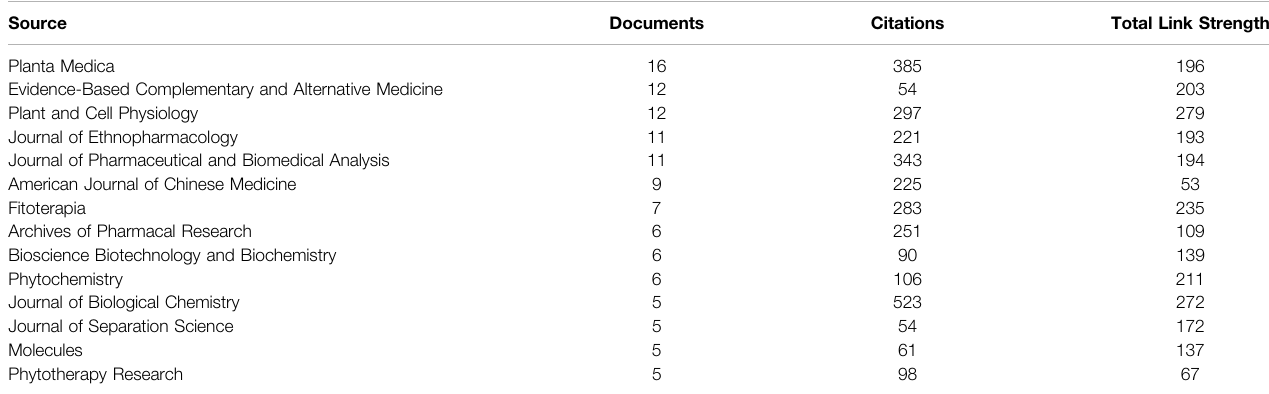
TABLE 1 | Journals that appeared at least 5 times in coupling